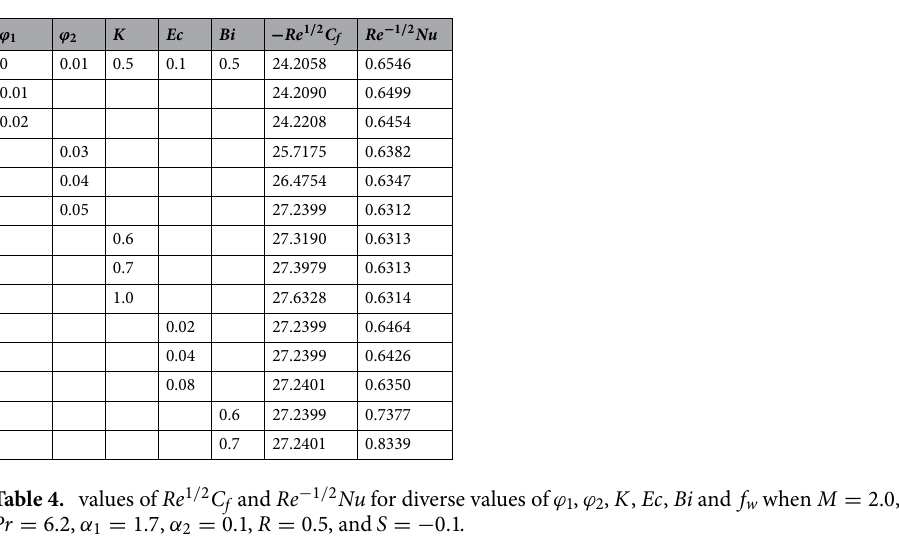
Table 4. values of Re 1 / 2 C f and Re − 1 / 2 Nu for diverse values of ϕ 1 , ϕ 2 , K , Ec , Bi and f w when M 6.2 , α 1 0.5 , and S 0.1 1.7 , α 2 0.1 , R Pr = = = − = =